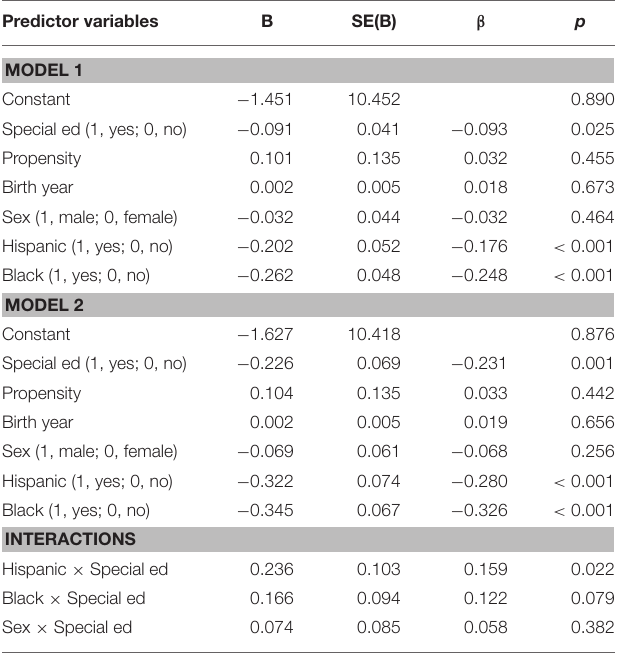
TABLE 10 | Hierarchical multiple regression analyses predicting family conflict ( n =